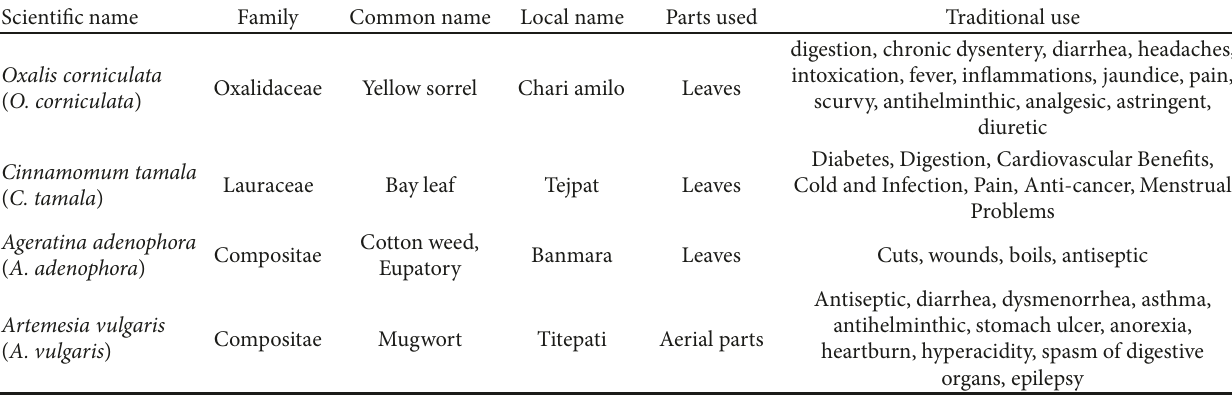
Table 1: Medicinal plants tested for their antibacterial activity in the